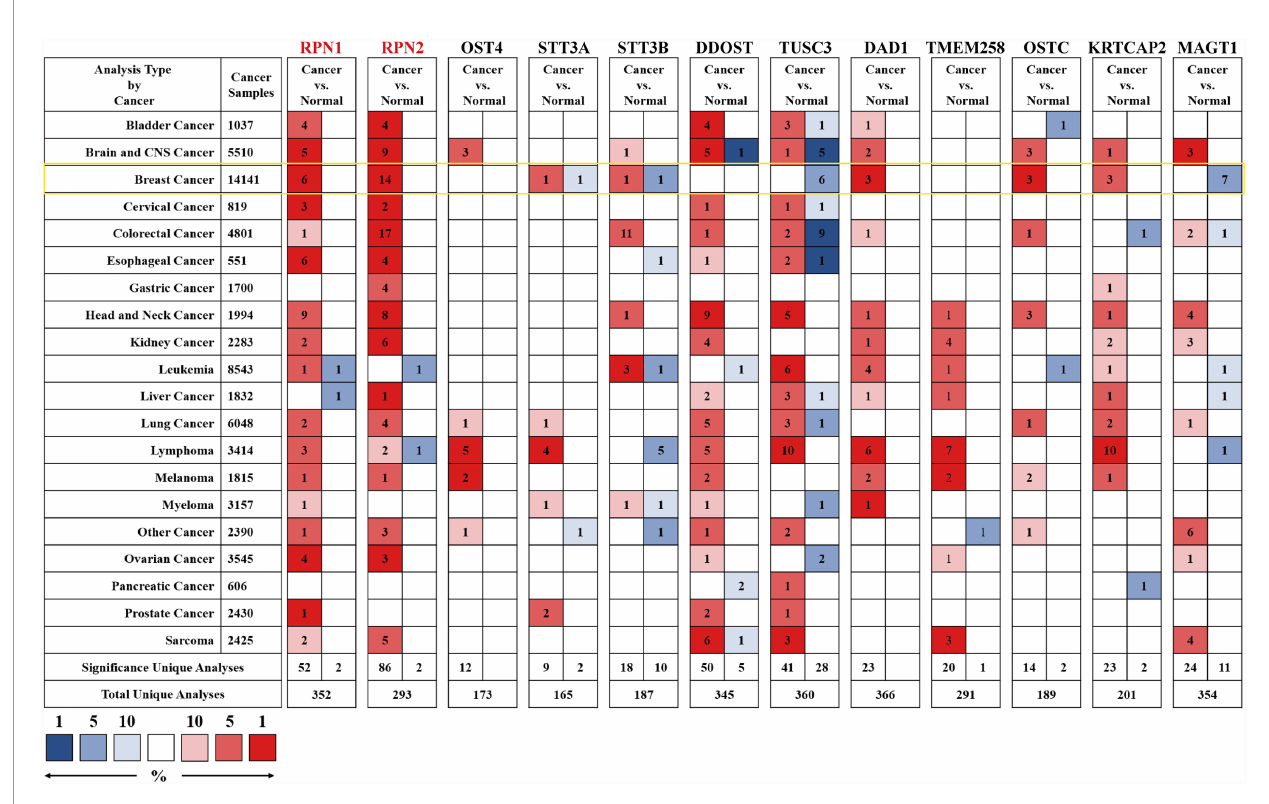
FIGURE 2 | The mRNA expression levels of the OST subunits in different types of human cancers (Oncomine). The fi gure was generated from Oncomine database with the thresholds that p-value, 0.0001; fold change, 1.5; gene rank: top 10%. The cell number represented the dataset number that met all of the thresholds with the color blue for low expression while the color red for high expression, and the cell color was determined by the best gene rank percentile for the analyses within the cell. An analysis might be counted in more than one cancer type. mRNA expression levels of OST subunits in breast cancer are delineated with yellow highlight. CNS, central nervous